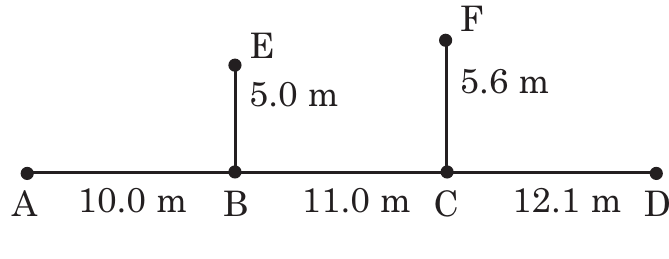
Figure 6. Power line configuration.